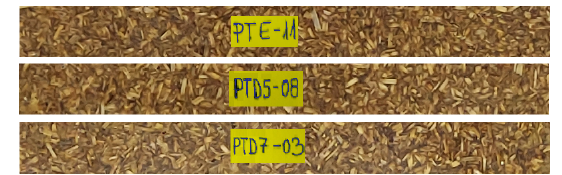
Figure 1. Test pieces submitted to tensile test.